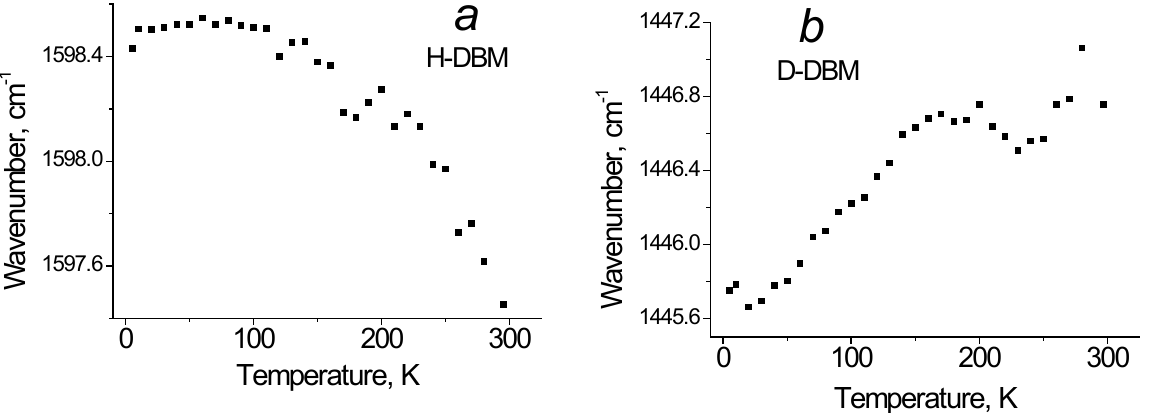
Figure 5. ( a , b ) Temperature dependence of the position of 1599 cm − 1 in H-DBM ( a ) and the 1445 cm − 1 D-DBM ( b ) band peak of the C=O stretching vibration of the enol cycle.